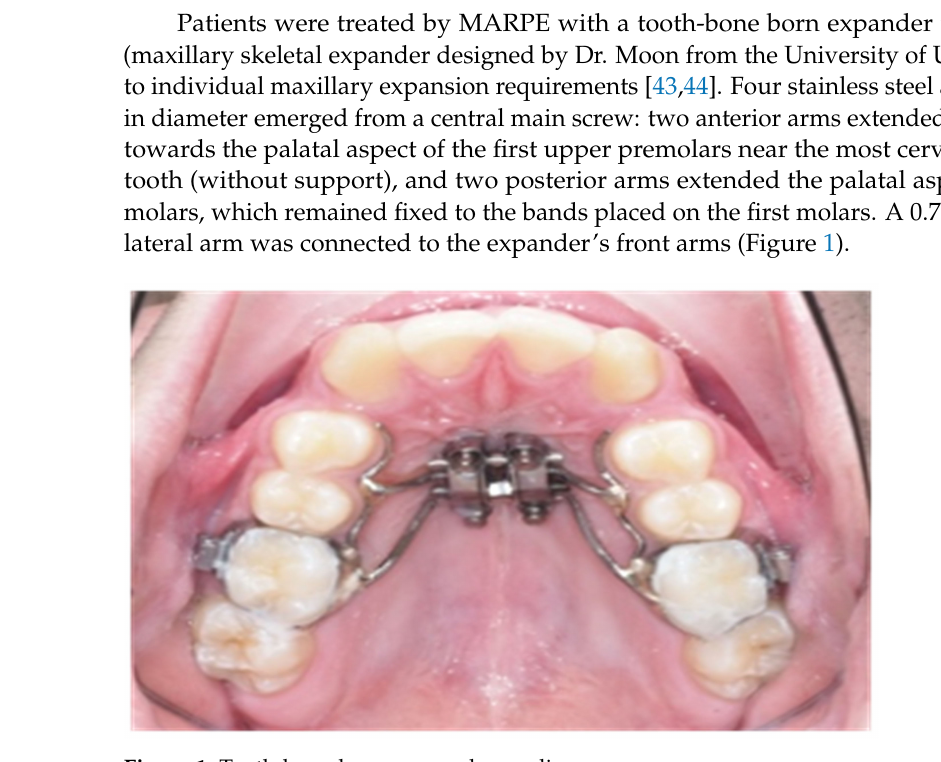
Figure 1. Tooth-bone-borne expander